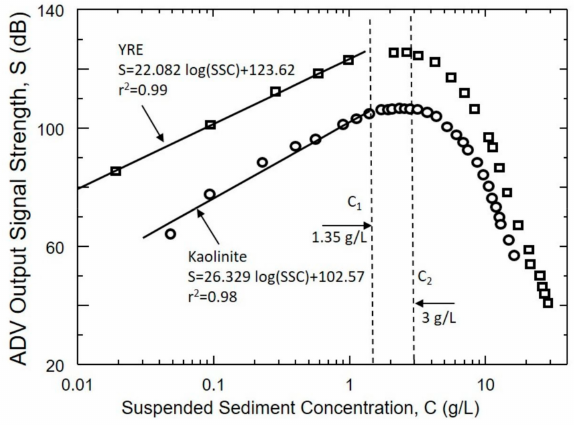
Figure 3. MicroADV responses to the cchnages of SSC for YRE sediment and kaolinite.